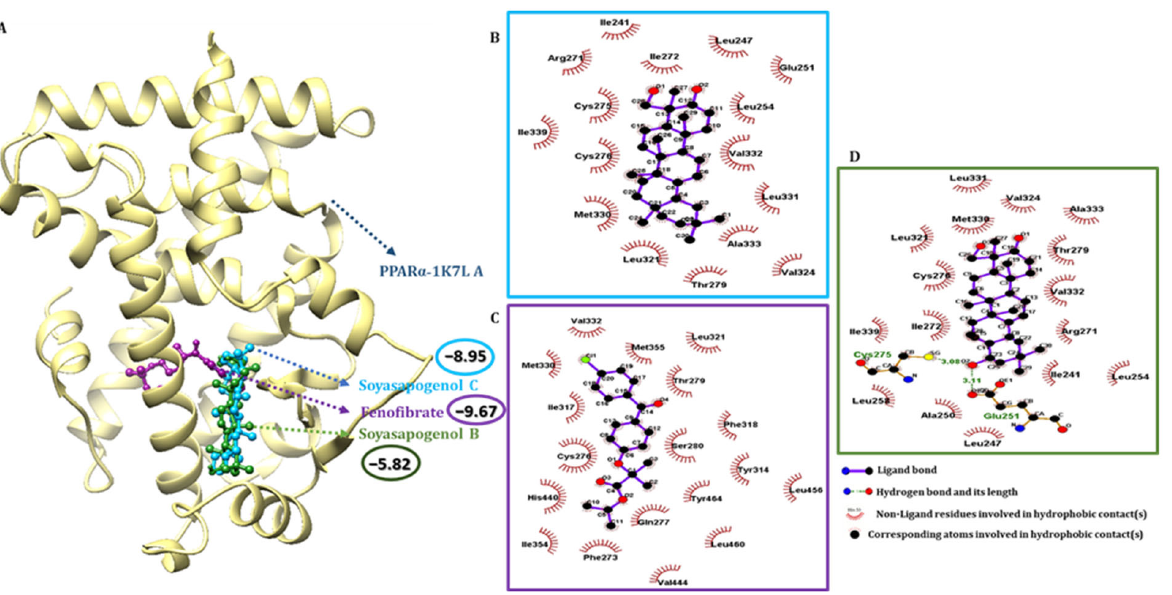
Figure 4. Molecular docking analysis using Auto Dock 4.2. ( A ) The binding interactions of soyasapogenol C (blue), soyasapogenol B (green) and fenofibrate (purple) with PPAR α protein (gold); ( B ) 2D pharmacophore analysis between PPAR α with active component soyasapogenol C (blue box); ( C ) 2D pharmacophore analysis between PPAR α with control compound fenofibrate (purple box); ( D ) 2D pharmacophore analysis between PPAR α with active component soyasapogenol B (green box).